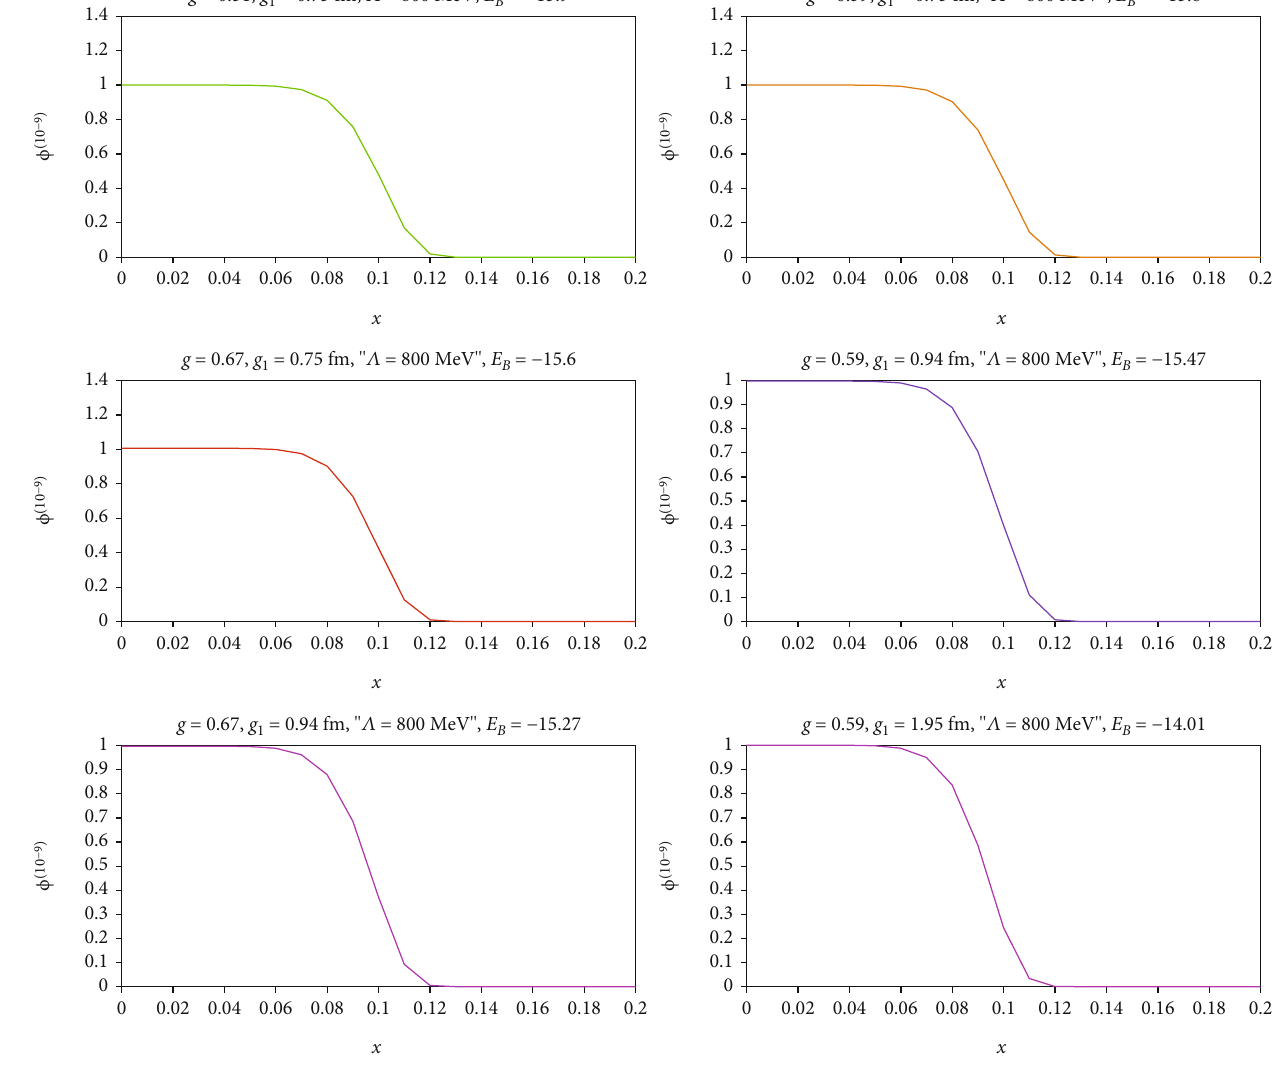
ð 4380 Þ at r in Λ = 800MeV for di ff erent values of g and g Figure 2: P c